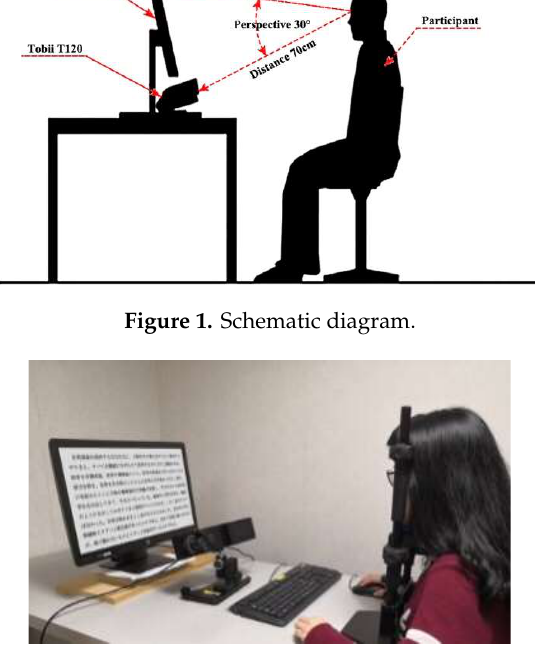
Figure 2. Experimental set-up.